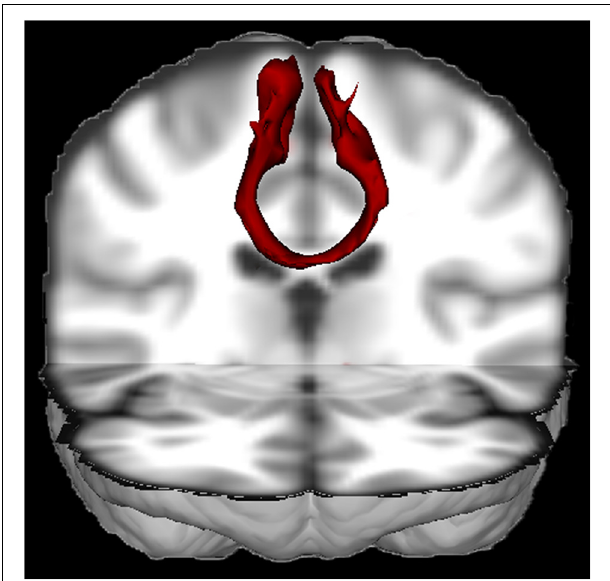
FIGURE 2 | Pre- and post-operative MRI scan of a 64-year-old patient with a diffuse astrocytoma (WHO grade II) in the left SMA. (A) Transversal and coronal T2-weighted FLAIR images, with an SMA template projected on the healthy hemisphere. The latter is freely available and derived from a large meta-analysis describing the location of the sensorimotor areas (Mayka et al., 2006). (B) Transversal images after gadolinium contrast from the same patient before (left lower corner) and three months after the operation (right lower corner). She had a complete motor loss on the right side after the operation, which quickly